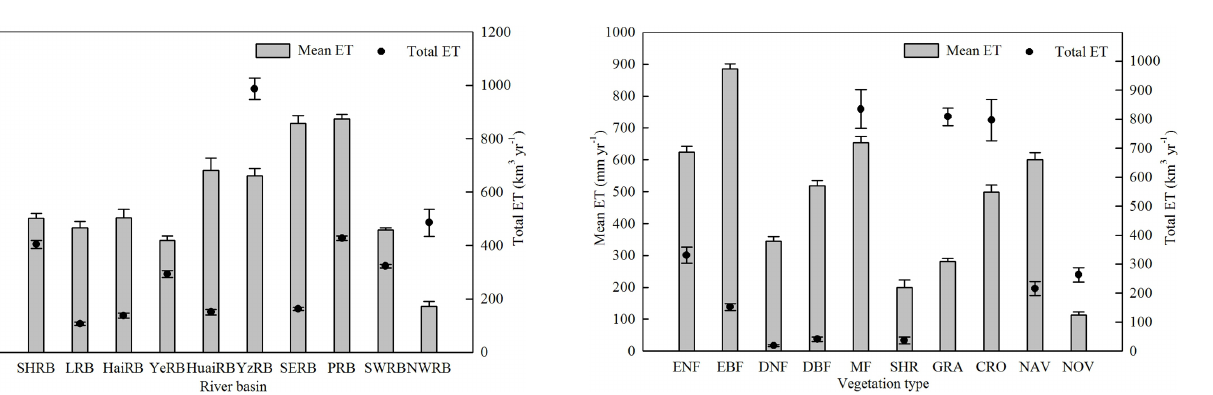
Fig. 7. Mean ET and total ET of different land cover types dur- ing the period from 2000 to 2010: ENF – evergreen needleleaf for- est; EBF – evergreen broadleaf forest; DNF – deciduous needle- leaf forest; DBF – deciduous broadleaf forest; MF – mixed